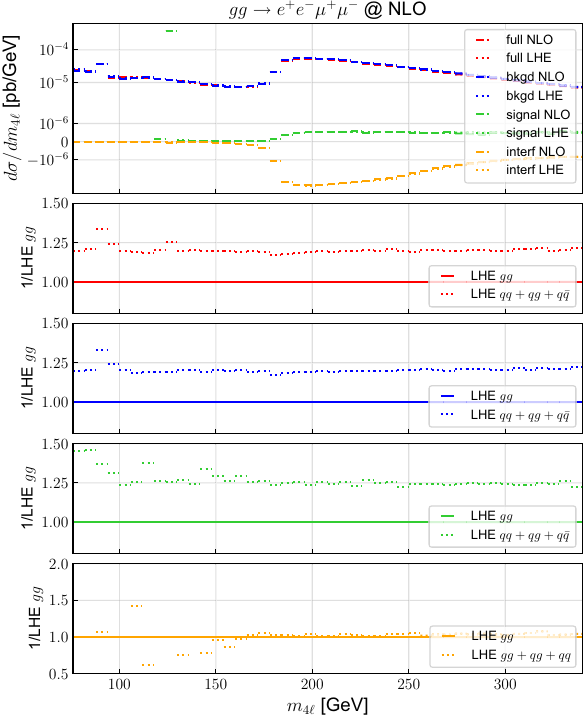
Fig. 12 Differential distribution in invariant mass m 4 (cid:3) of the four- lepton system in gg → e + e − μ + μ − at NLO and LHE level. Colour coding of the different production modes as in Fig. 3. The lower ratio plots show the full LHE contribution including all partonic channels ( gg + qg + qq ) over only the gg channel contribution for the different production